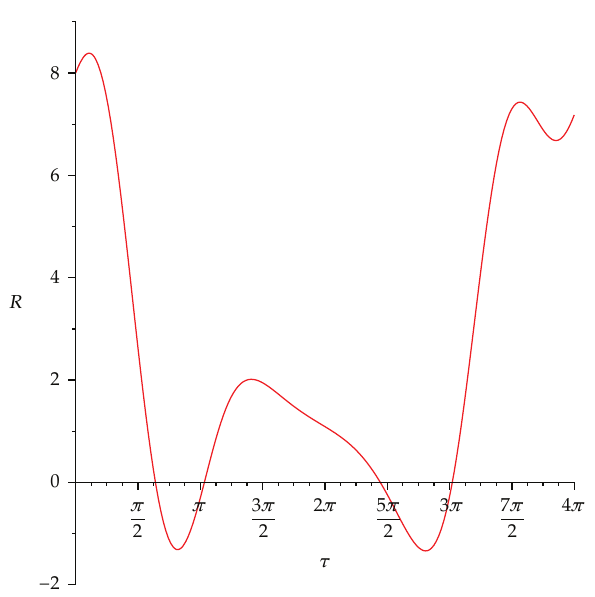
Figure 35: The evolution of the R with respect of the cosmic time τ for (cid:2) 5.33 (cid:3)